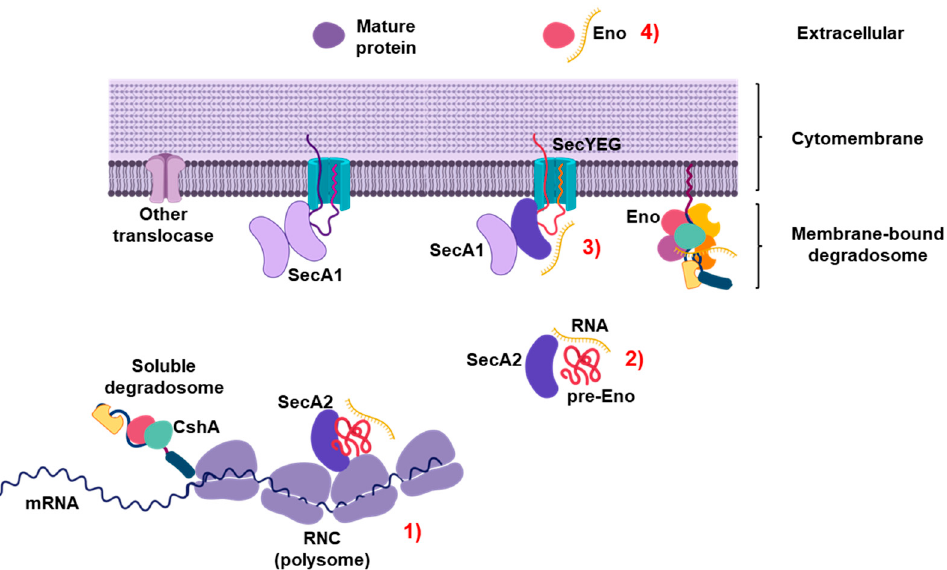
Figure 8. A model of SecA2-dependent secretion of proteins and RNAs in L. monocytogenes . (1, 2) SecA2 interacts with translating ribosomes and thereby recognizes SecA2-dependent proteins co- translationally at ribosome-nascent chain complexes (RNC). (3) SecA2 associates with the canonical SecYEG/SecA1 channel. It is suggested that SecA2 either forms homodimers like SecA1 or SecA1 supports SecA2-dependent translocation by heterodimerization with SecA2. (4) The SecA2-dependent protein enolase is a part of the RNA degradosome close to RNCs or at the inner cytomembrane and binds individual RNAs e.g., rli32. SecA2 targets enolase to the SecYEG channel and facilitates the translocation of enolase together with its associated sRNAs in the supernatant.